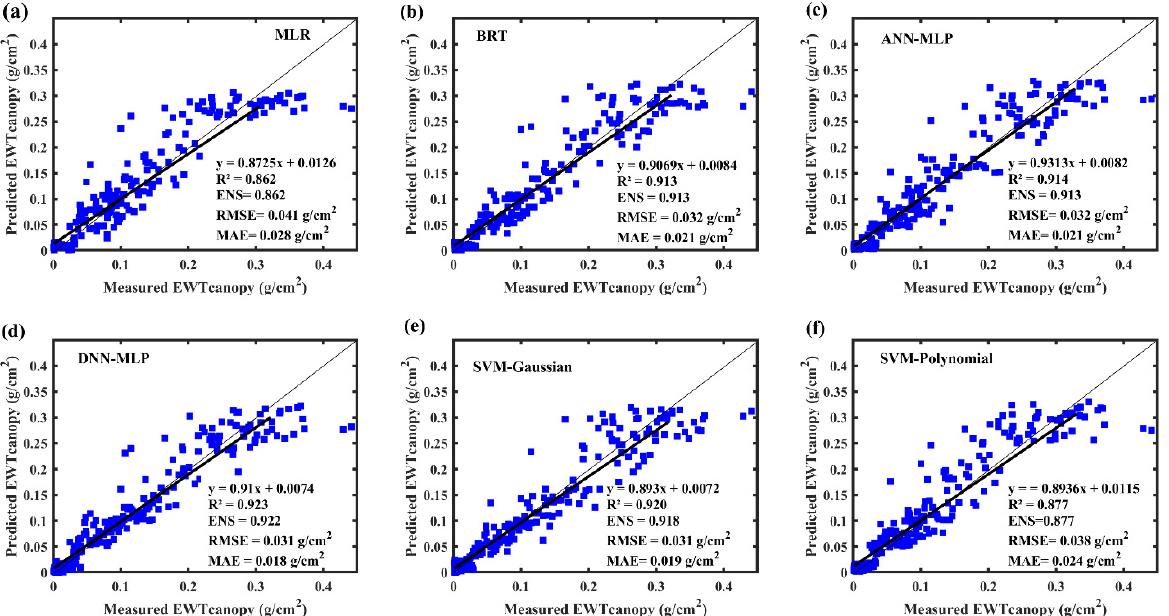
Figure 9. Scatter plots of EWT canopy calculated from predicted FW and DW according to multiple linear regression (MLR, a ),